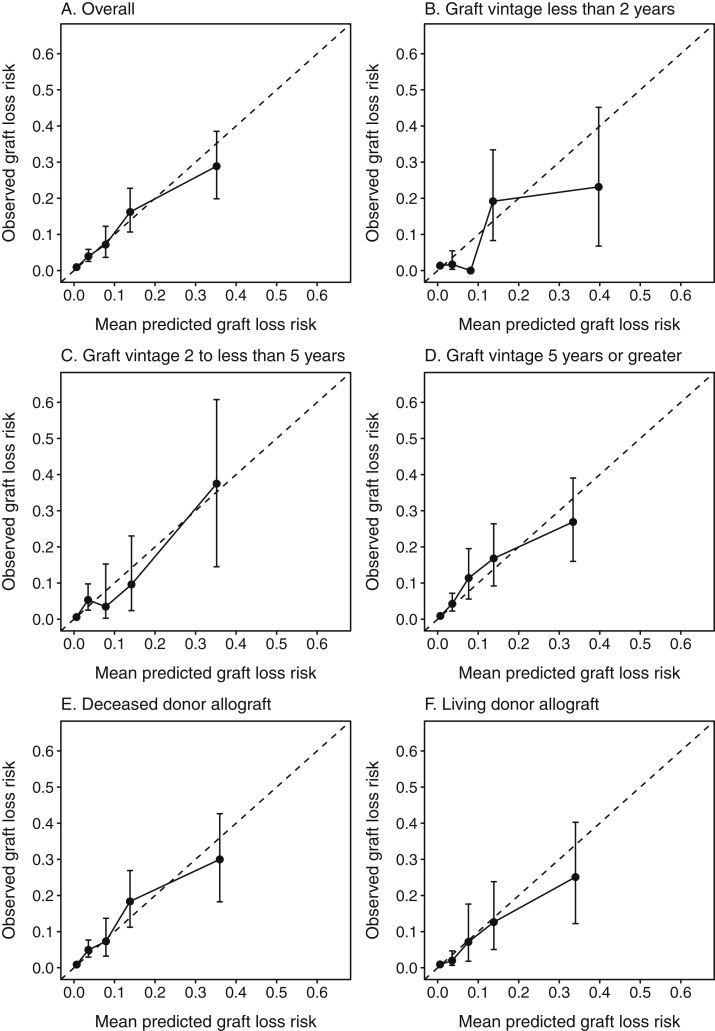
Observed versus predicted graft loss risk using 4-variable Kidney Failure Risk Equation at 2 years. The dotted line denotes perfect agreement between observed and predicted risk. Error bars represent 95% CIs for cumulative incidence of graft loss with return to dialysis within 2 years. (B) Error bars are not shown for the 6% to <10% predicted risk category because 0 of the 34 corresponding participants had experienced graft loss by the 2-year time point.